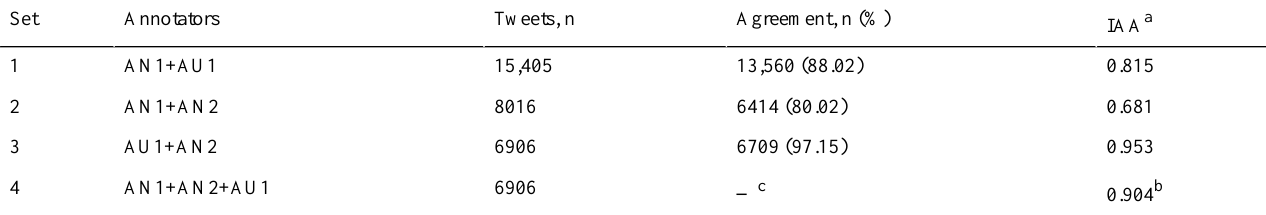
Table 2. Annotation agreement